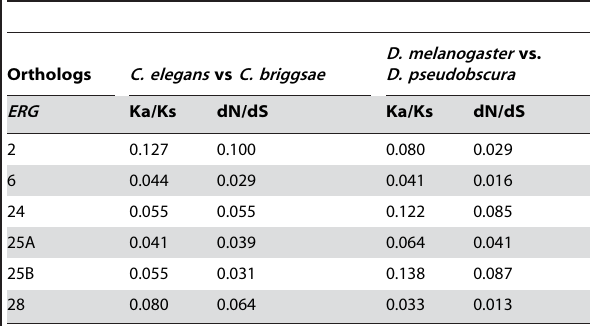
Table 1. Ka/Ks and dN/dS values for several orthologs of ERG genes in the fruitfly and the worm.